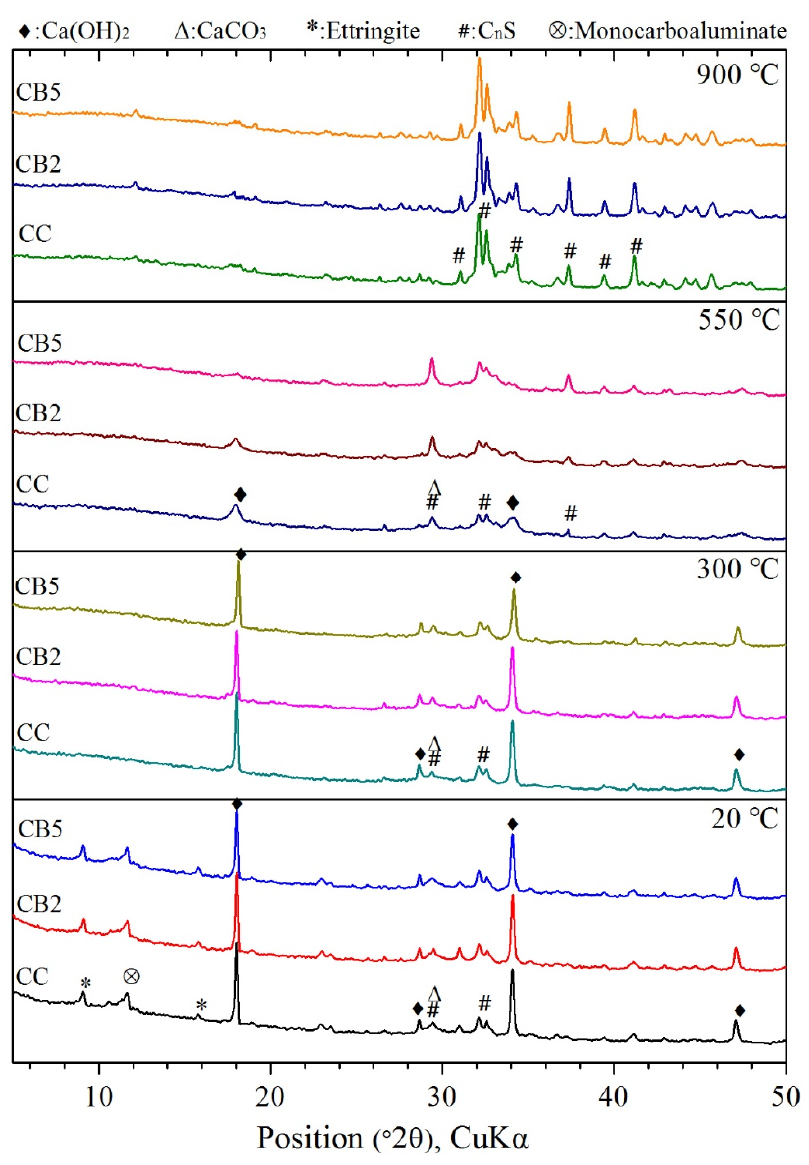
Figure 6. XRD analysis of specimens exposed to 20, 300, 550 and 900 °C.